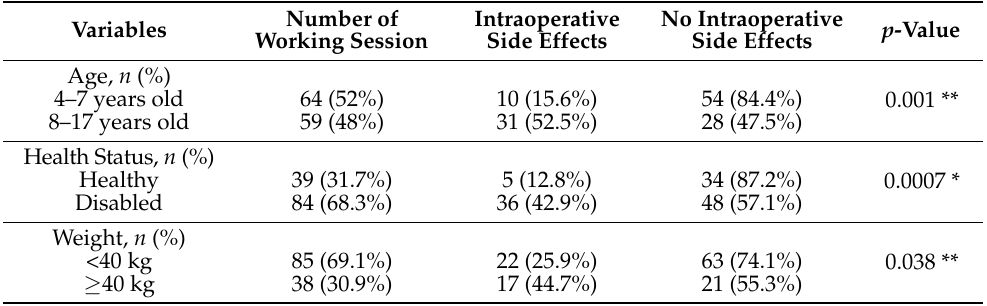
Table 1. Statistical significance of intraoperative side effects in relation to the characteristics of the